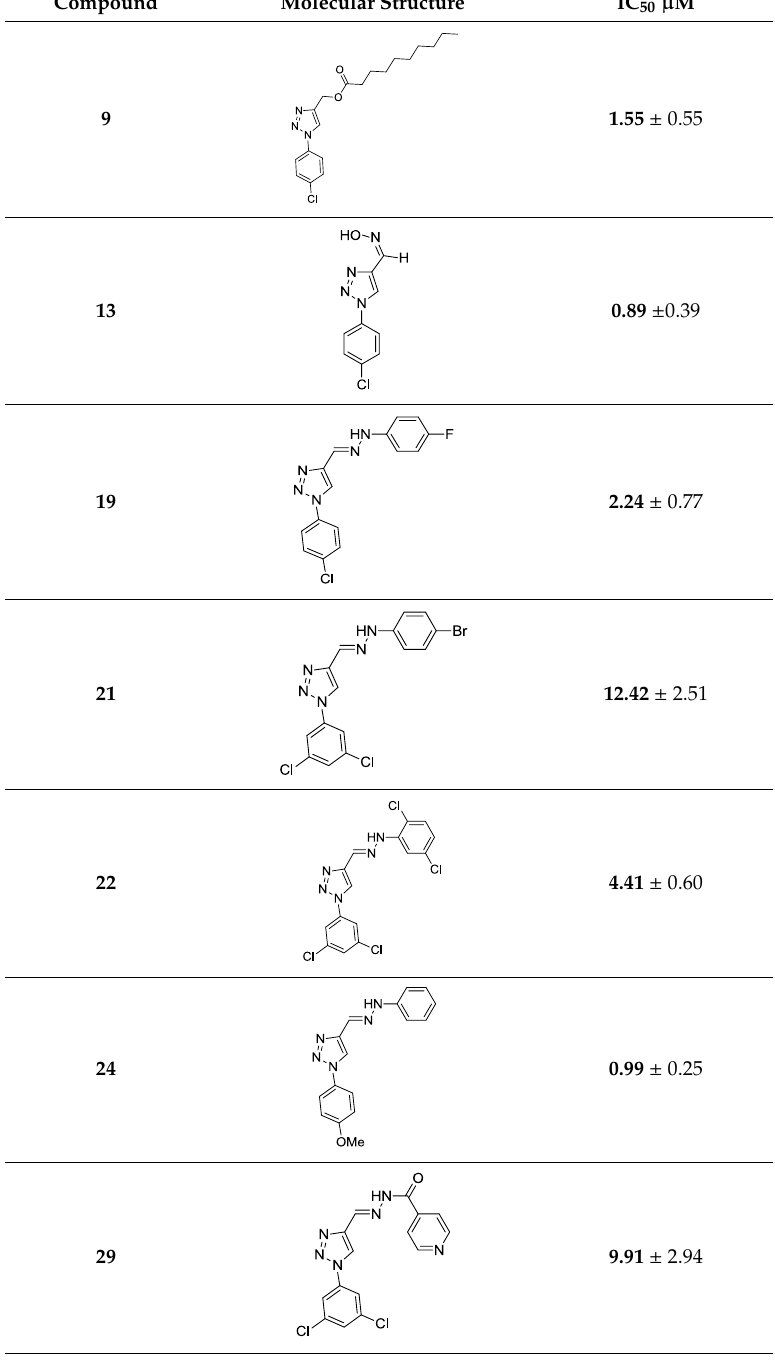
The results expressed in Table 2 refer to experiments carried out with eight compounds with Table 2. Results obtained with the screening of compounds in the knockout P. falciparum for the PfSR25 Table 2. Results obtained with the screening of compounds in the knockout P. falciparum for the Table 2. Results obtained with the screening of compounds in the knockout P. falciparum for the Table 2. Results obtained with the screening of compounds in the knockout P. falciparum for the (PfSR25-) receptor; molecular structure of each compound; IC 50 values with the standard error of Table 2. Results obtained with the screening of compounds in the knockout P. falciparum for the Table 2. Results obtained with the screening of compounds in the knockout P. falciparum for the Table 2. Results obtained with the screening of compounds in the knockout P. falciparum for the PfSR25 (PfSR25-) receptor; molecular structure of each compound; IC 50 values with the standard error Table 2. Results obtained with the screening of compounds in the knockout P. falciparum for the PfSR25 (PfSR25-) receptor; molecular structure of each compound; IC 50 values with the standard error PfSR25 (PfSR25-) receptor; molecular structure of each compound; IC 50 values with the standard error the mean. PfSR25 (PfSR25-) receptor; molecular structure of each compound; IC 50 values with the standard error PfSR25 (PfSR25-) receptor; molecular structure of each compound; IC 50 values with the standard error PfSR25 (PfSR25-) receptor; molecular structure of each compound; IC 50 values with the standard error of the mean. PfSR25 (PfSR25-) receptor; molecular structure of each compound; IC 50 values with the standard error of the mean. of the mean. of the mean. of the mean. of the mean. of the